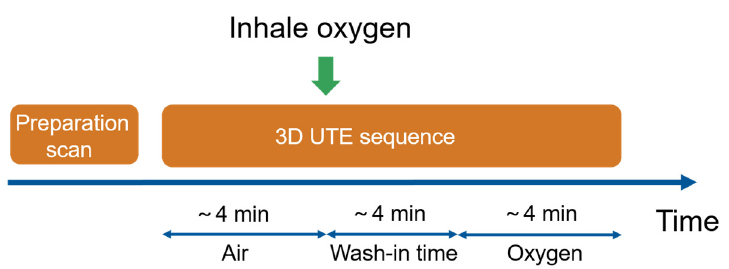
Figure 1. Flow chart of the experiment protocol using 3D UTE sequence with radial acquisition. Preparation scan is about 3 min for localization and shimming; hence, the total experiment time is approximate 15 min.